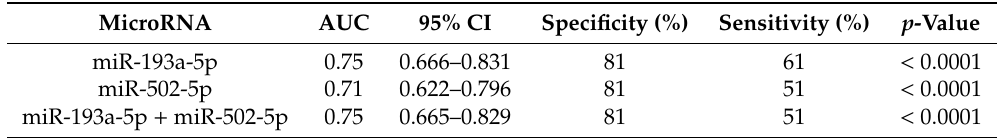
Figure 5. Receiver operator characteristic (ROC) curve analysis of circulating miR-193a-5p and miR-502-3p among ILA and Ctrl. Graphs show the ROC curve of miR-193a-5p and miR-502-3p as a single biomarker for predicting the presence of interstitial lung abnormalities in asymptomatic subjects. AUC: area under the curve. ILA: subjects with interstitial lung abnormalities. Ctrl: control group. Table 2. Diagnostic accuracy values of miR-193a-5p and miR-502-3p as a single and combined biomarker for predicting the presence of ILA in asymptomatic